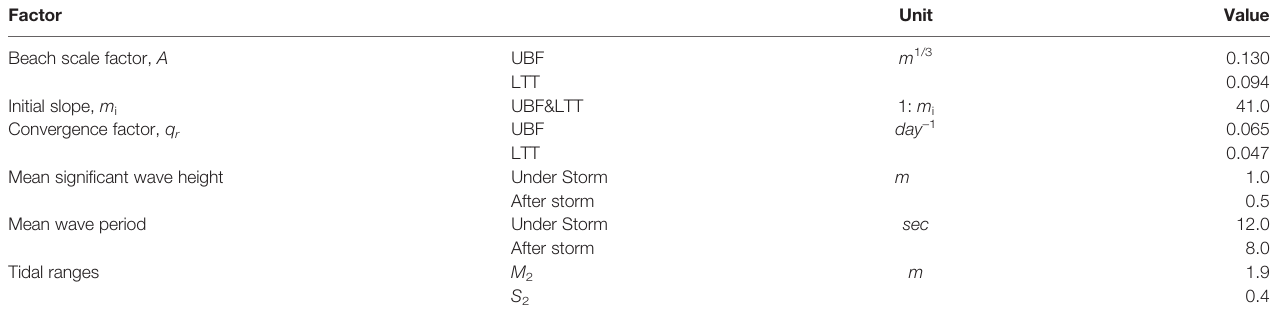
TABLE 2 | Input conditions for prediction result of beach pro fi le change.